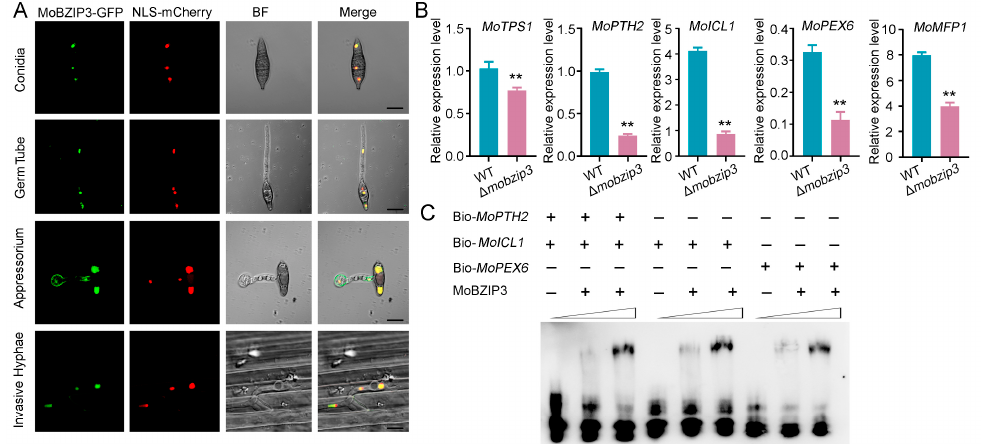
Figure 5. MoBZIP3 may function as a transcription factor. ( A ), Localization analysis of MoBZIP3 . MoBZIP3 -GFP driven by its native promoter was expressed in NLS-mCherry labeled ∆ mobzip3 . Both GFP and mCherry were observed under fluorescence microscopy in the M. oryzae conidia, germ tube, appressorium and invasive hyphae. Bar = 10 µ m. ( B ), Quantitative real-time PCR analysis expression of MoTPS1 , MoPTH2 , MoICL1 , MoPEX6 , MoMFP1 in WT and ∆ mobzip3 . The experiments were repeated three times with similar results. Error bars represent ± SE of three biological replicates. Asterisks represent a significant difference (** p < 0.01). Primers used in this experiment were listed in Supplemental Table S1. ( C ), EMSA showing MoBZIP3 could directly bind to the promoter fragment of MoPTH2 , MoICL1 and MoPEX6 .